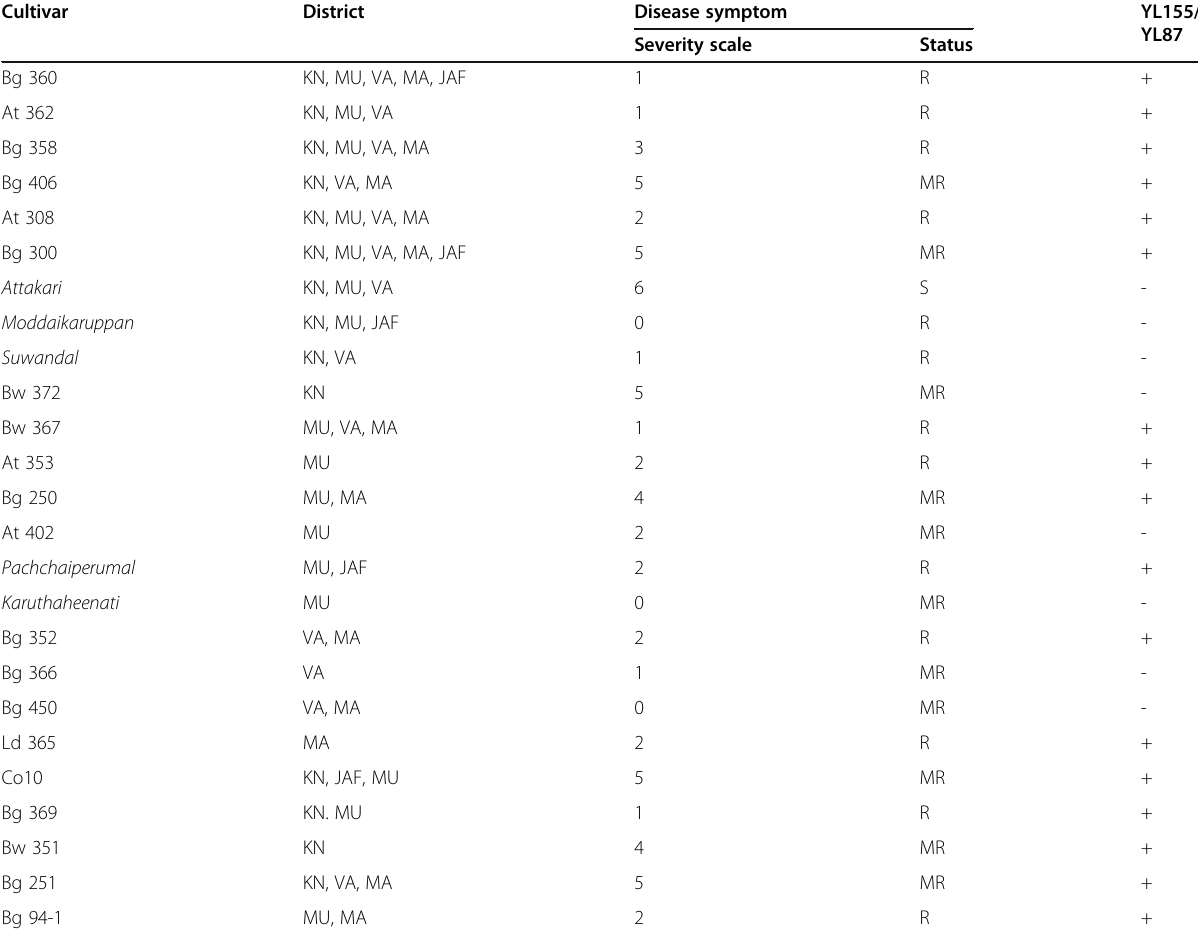
Table 5 List of 25 cultivars from the Northern Province of Sri Lanka and their response in the pathogenicity assay ( KN , Kilinochchi; MU , Mullaitheevu; MA , Mannar; VA , Vavuniya; JFN , Jaffna; ‘ + ’ represents the presence and ‘ - ’ represents the absence of amplicon in the specific PCR assays)